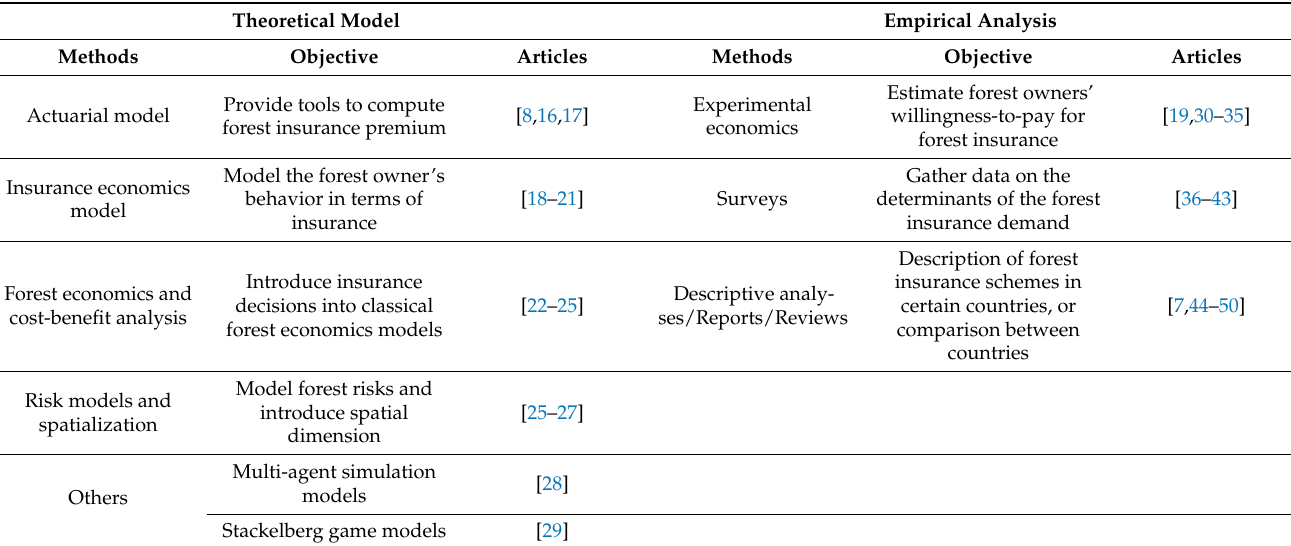
Table 3. Summary of the